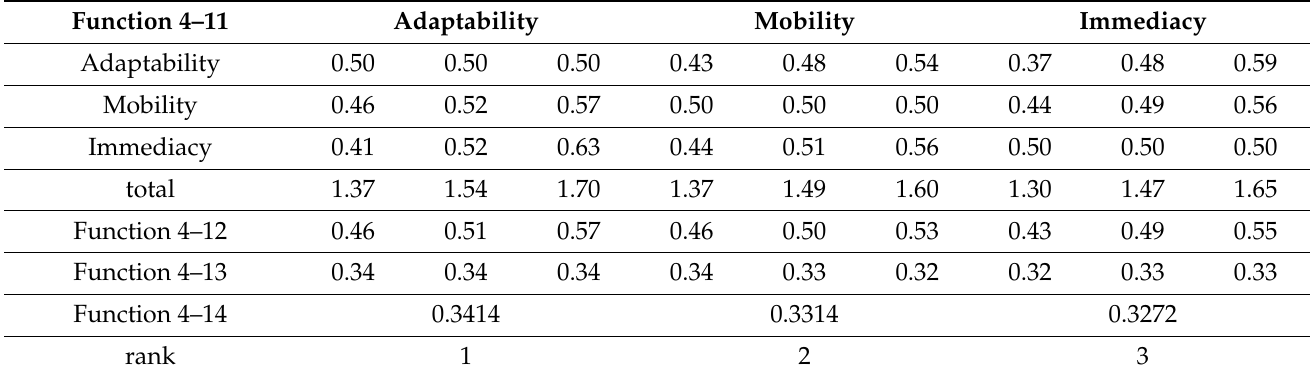
Table A5. Aviation companies’ weights of attributes of the conditional value.